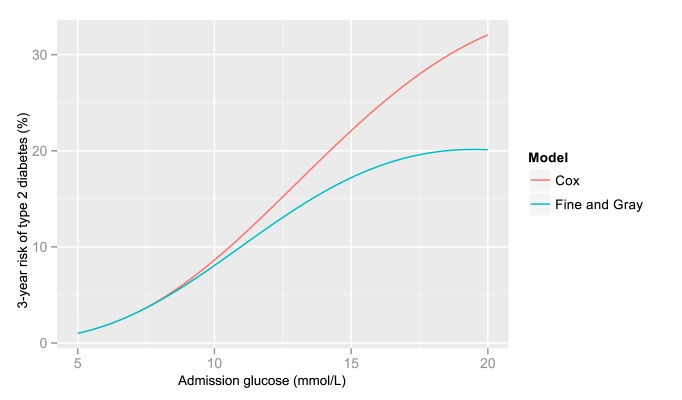
3-year risk of type 2 diabetes and competing risks.Estimates of 3-year risk of type 2 diabetes in women aged 60 obtained by multiplying the risk in women aged 60 with a glucose of 5 mmol/L (1.0%, obtained from the logistic regression model in Table 4) by the csHR and the sdHR, respectively.